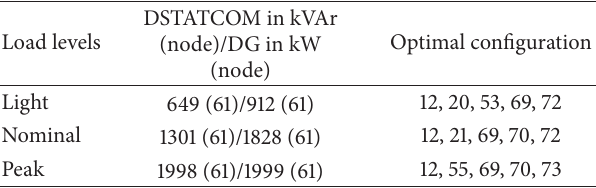
Table 3: Optimal solution for DSTATCOM and DG